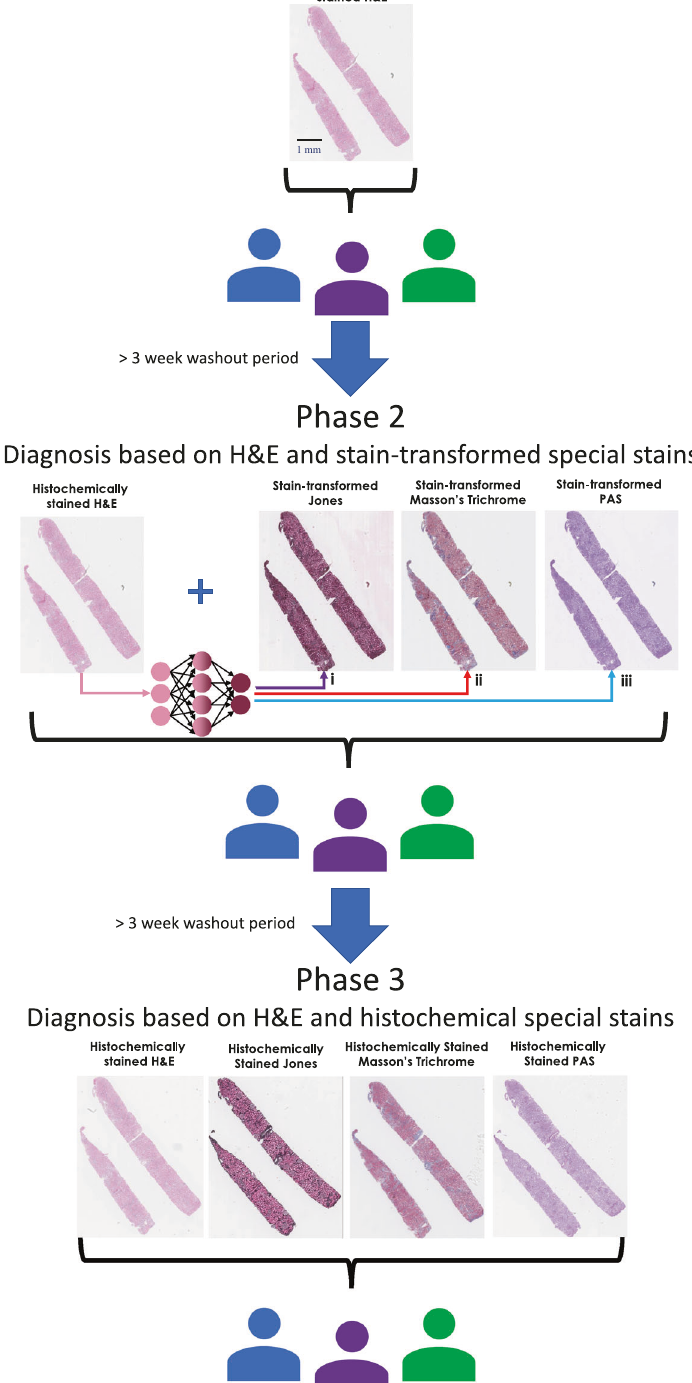
Fig. 3 Overview of the study design. Phase 1 shows the initial portion of the study where three pathologists review H&E WSIs of N = 58 different tissue sections (each from a unique patient). After a >3-week washout period, the second phase of diagnosis is performed, where the same three pathologists view the same WSIs, where, in addition to the H&E, the special stains generated by the stain transformation technique (PAS, Masson ’ s Trichrome, Jones) are provided as well. After an additional >3-week washout period, the third phase of diagnosis is performed, where the same three pathologists again review the same WSIs. For this phase, instead of using special stains generated through the stain transformation technique, the images of all four stains (H&E, PAS, Masson ’ s Trichrome, and Jones) come from histochemically stained serial sections. (i) Generation of JMS. (ii) Generation of MT. (iii) Generation of